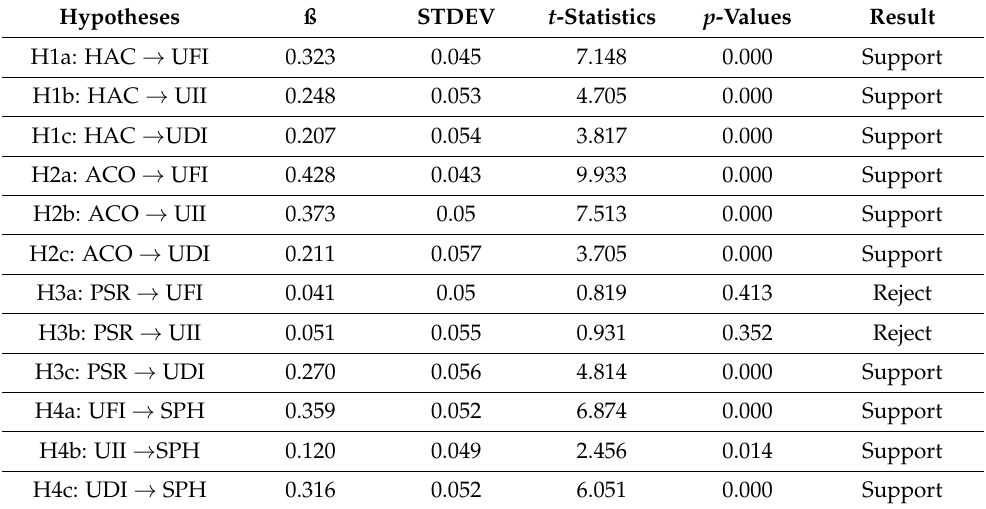
Table 6. Hypothesis testing results.